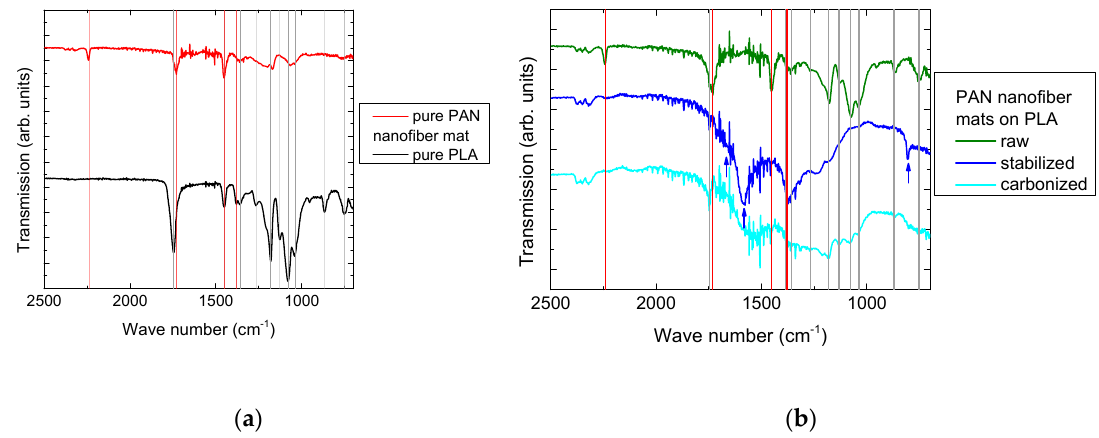
Figure 6. FTIR spectra of ( a ) pure PAN and pure poly (lactic acid) (PLA) for comparison, with some prominent peaks marked and ( b ) PAN nanofiber mats in raw, stabilized, and carbonized state on PLA.